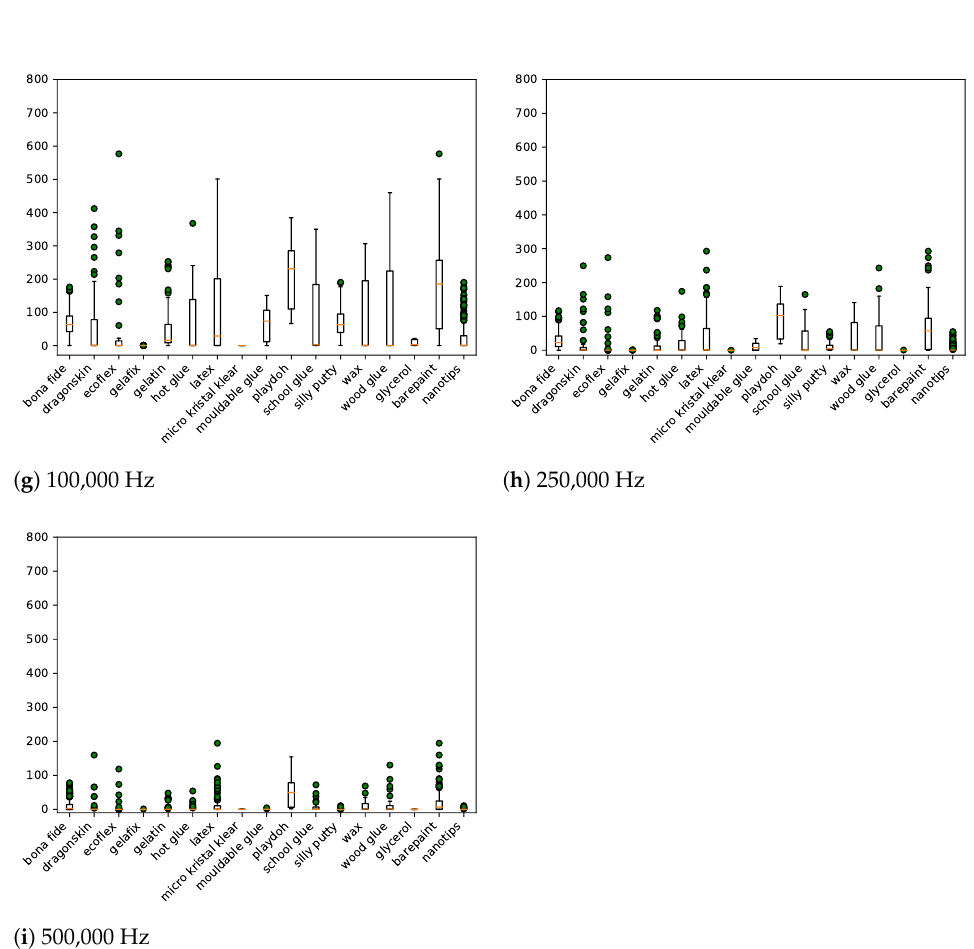
Figure A1. For each frequency ( a – i ), the plots visualise the impedance values using the median (orange), ± 25% (box), the standard deviation (end of line), and outliers (green dots) for all conductive